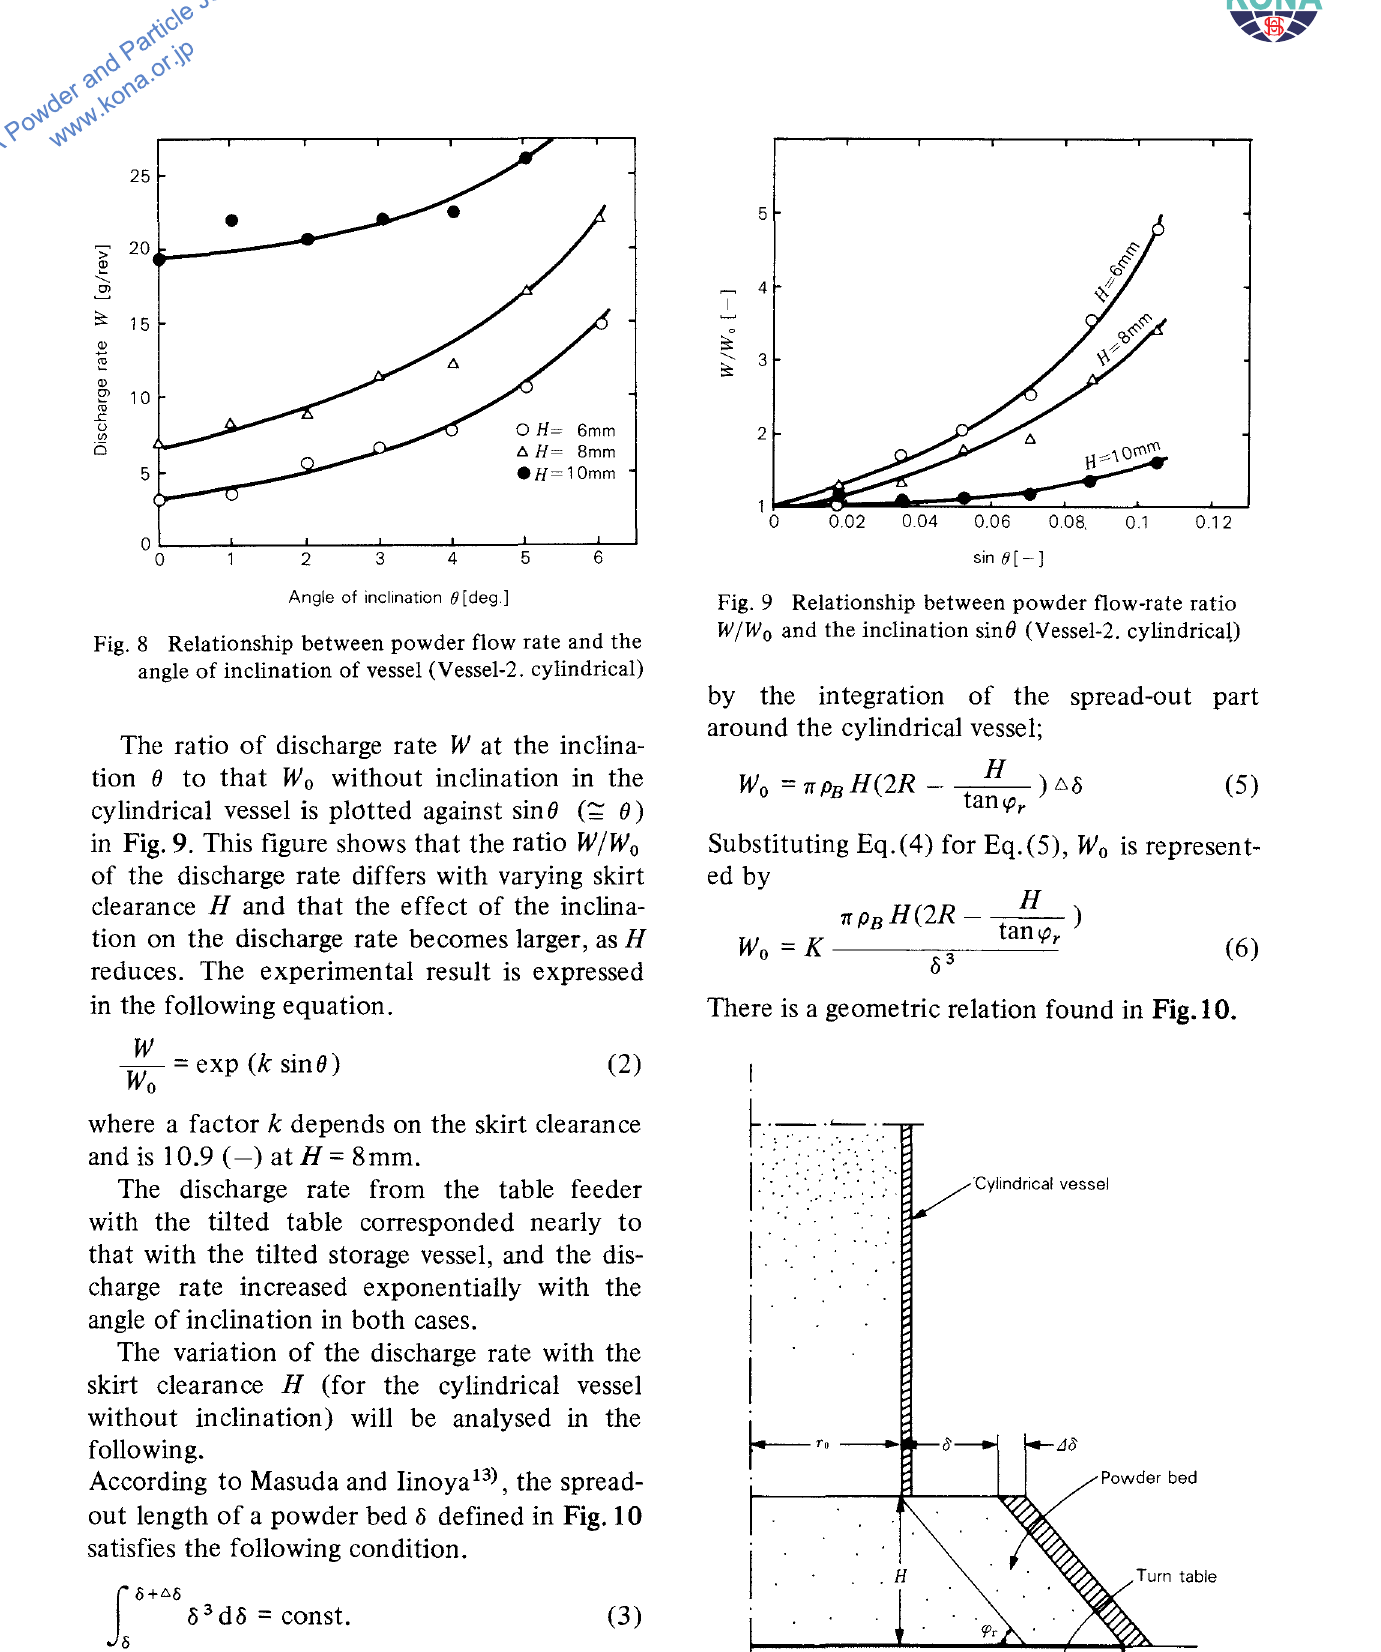
Fig. 10 Schematic diagram of powder bed on the table